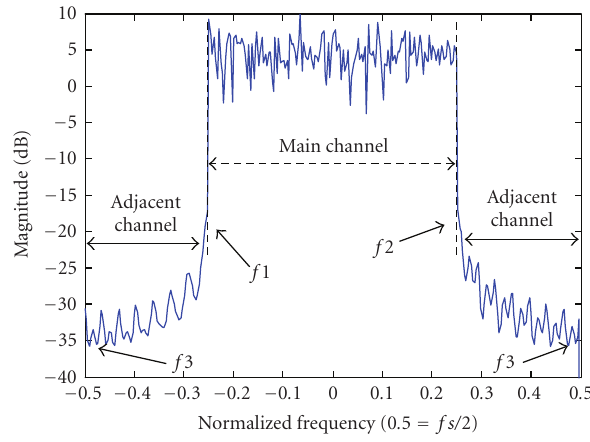
Figure 7: NLA distortion versus a , with s = 0 . 8.